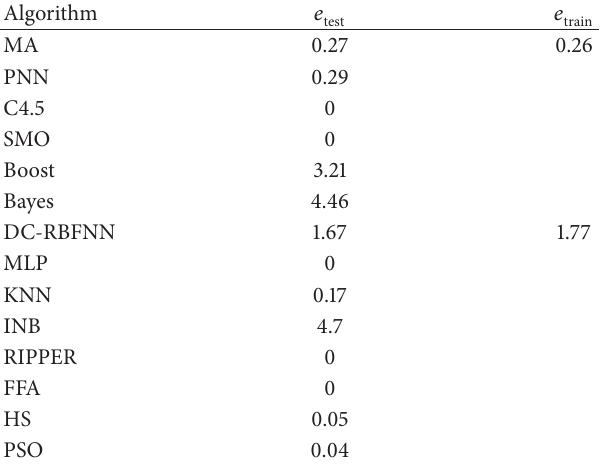
Table 8: Results in the mushroom